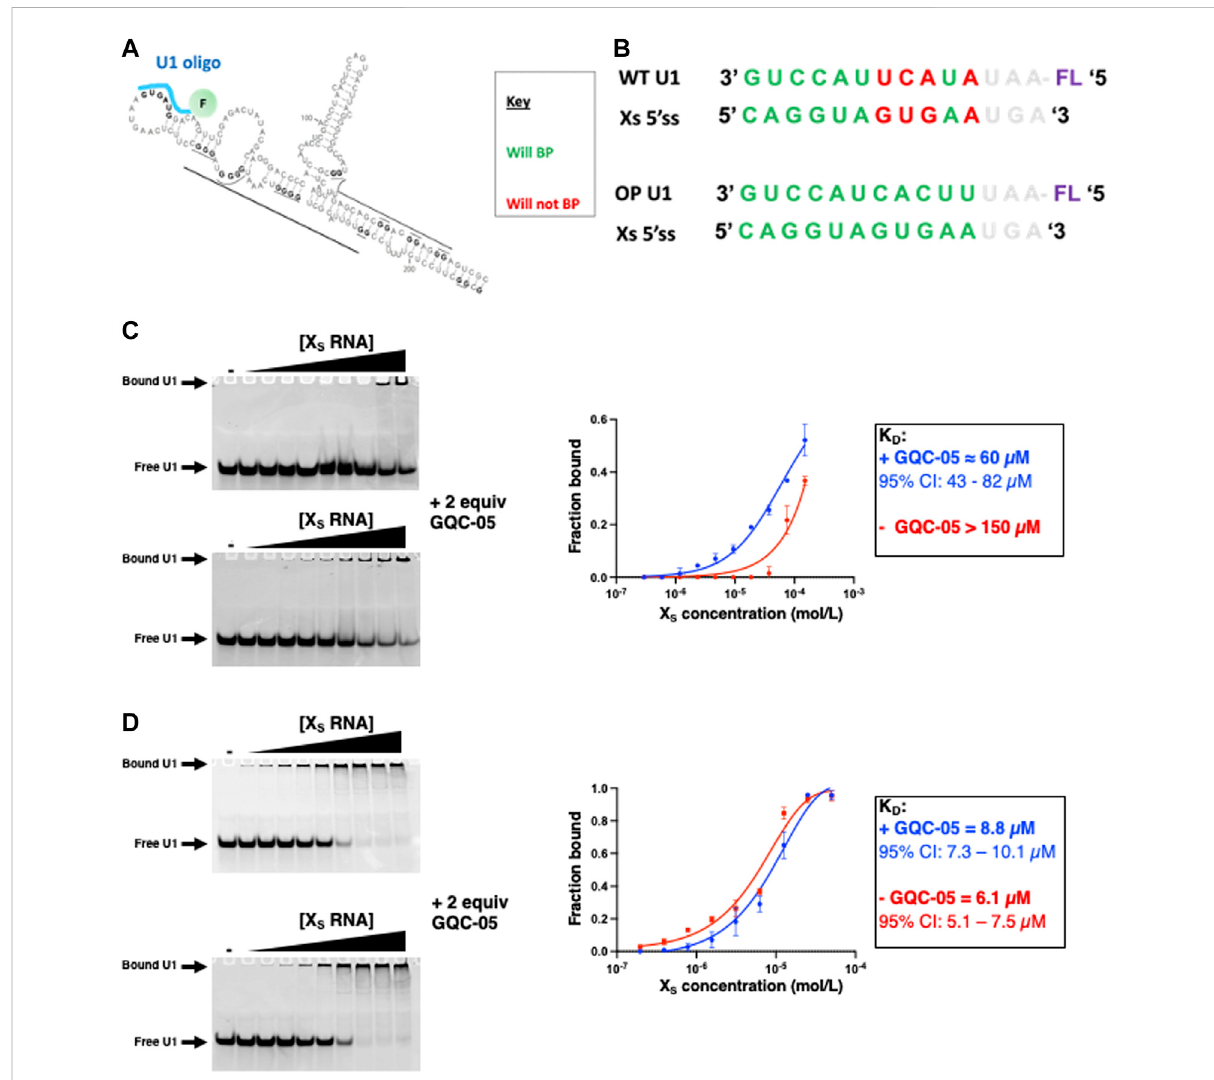
FIGURE 11 ProbingtheX S 5 ′ ssaccessibilityusing fl uorescently labelledU1oligos (A) Schematicshowingtheproposedbindingofthe fl uorescentlylabelled U1 oligo (cyan) (B) Sequences of the U1 WT and OP (optimised) oligo and their ability to base pair the X S 5 ’ ss (C – D) EMSA assays with a fl uorescein labelled wild-type (C) and optimised (D) U1 oligo at 6 µM as a function of the X S RNA concentration in the absence (Top gel) and presence (Bottom gel) of 2 equivalence of GQC-05 in 10 mM Tris pH 7.0 and 100 mM KCl. Samples were loaded on a 16% native polyacrylamide gel, ran at 4 ° C at 150 Vforapproximately60 min.GelswerevisualizedonaTyphoonscannerwitha488 nmexcitationand550 nmemissionwavelength.Thebinding isotherms are plotted on the right for the X S 5 ′ ss in the absence (red) and presence (blue) of